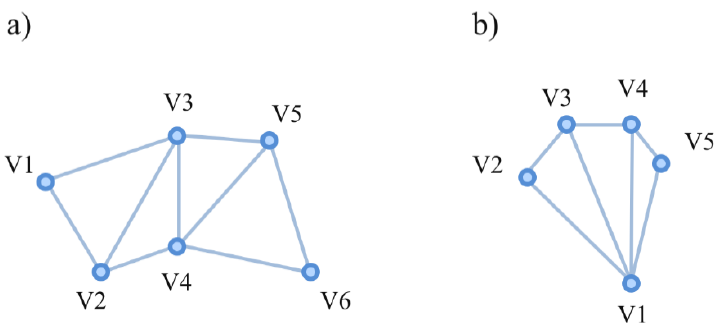
Figure 10. Two types of OpenGL geometric primitives: ( a ) triangle strip; ( b ) triangle fan.